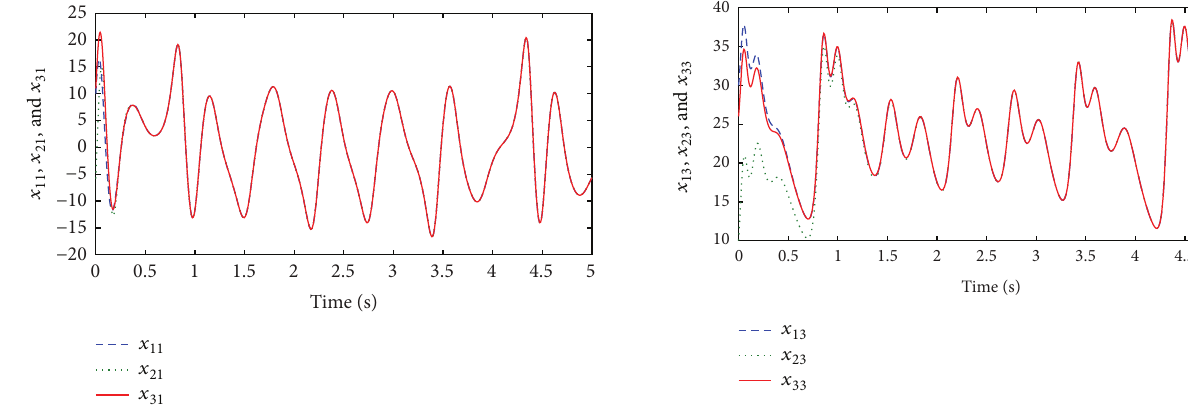
Figure 8: The state trajectories 𝑥 13 , 𝑥 23 , and 𝑥 33 of the chaotic sys- tems with time 𝑡